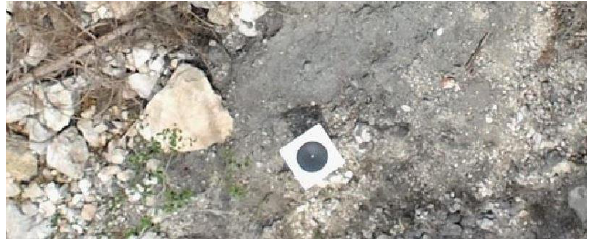
Figure 3. Ground control point